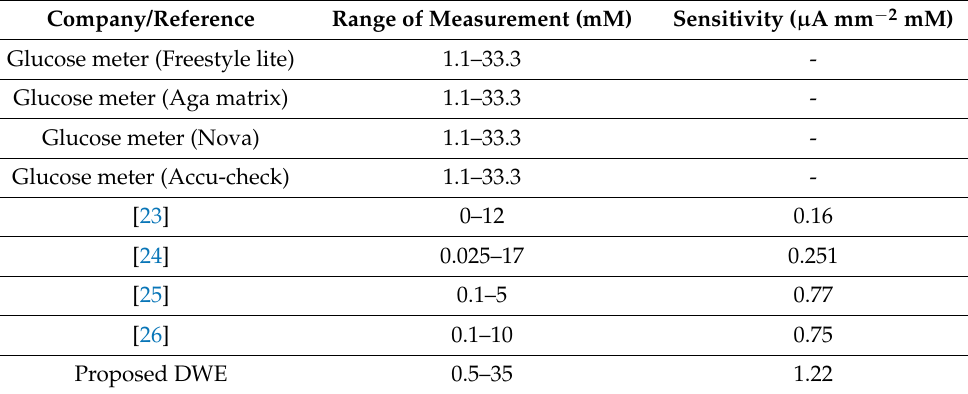
Figure 4. Sensitivity test: ( a ) CV responses of glucose solutions from 0.5 to 35 mM and ( b ) CV responses of lactate solutions from 0.5 to 25 mM. ( c , d ) Calibration curves of I p s with respect to glucose and lactate concentrations, which show a robust linear relationship. The measurement of each condition was conducted in triplicate. Table 1. Glucose sensitivity of DWE compared with those of commercial glucose meters and recent reports .